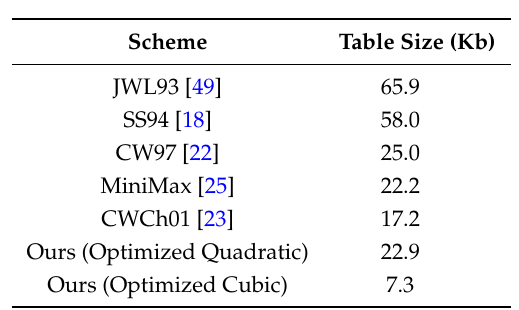
Table 8. Table size comparisons for four specific operations at 24-bit